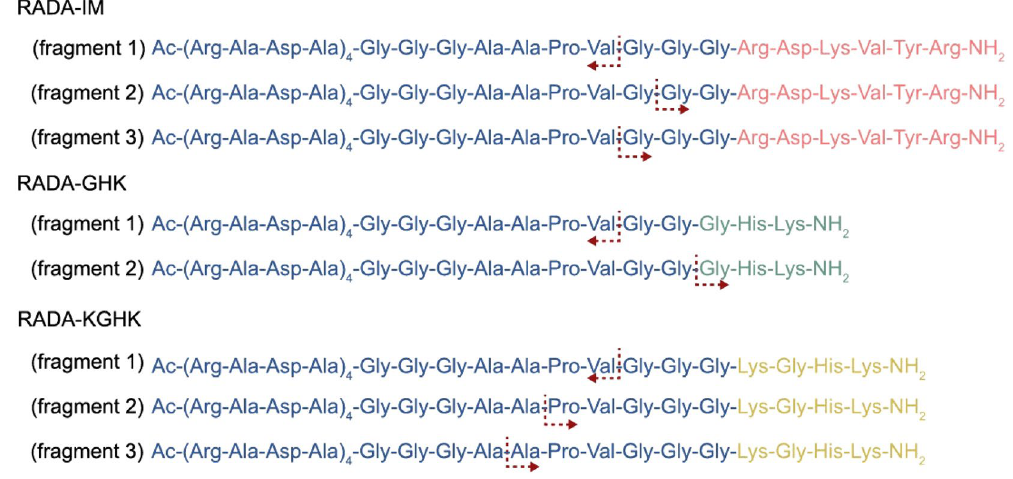
Figure 2. Elastase-digestion fragments of most abundant signals of peptide hybrids observed in mass spectrum analysis. The red arrows indicate the source of the identified degradation